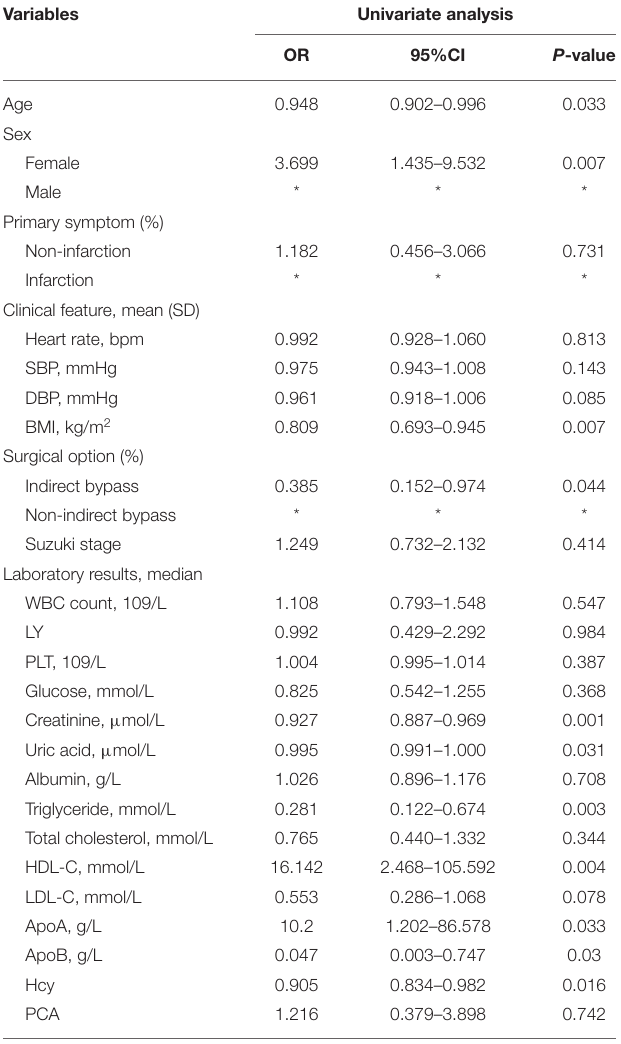
TABLE 3 | Univariate analysis of risk factors for patients with poor postoperative angiogenesis.